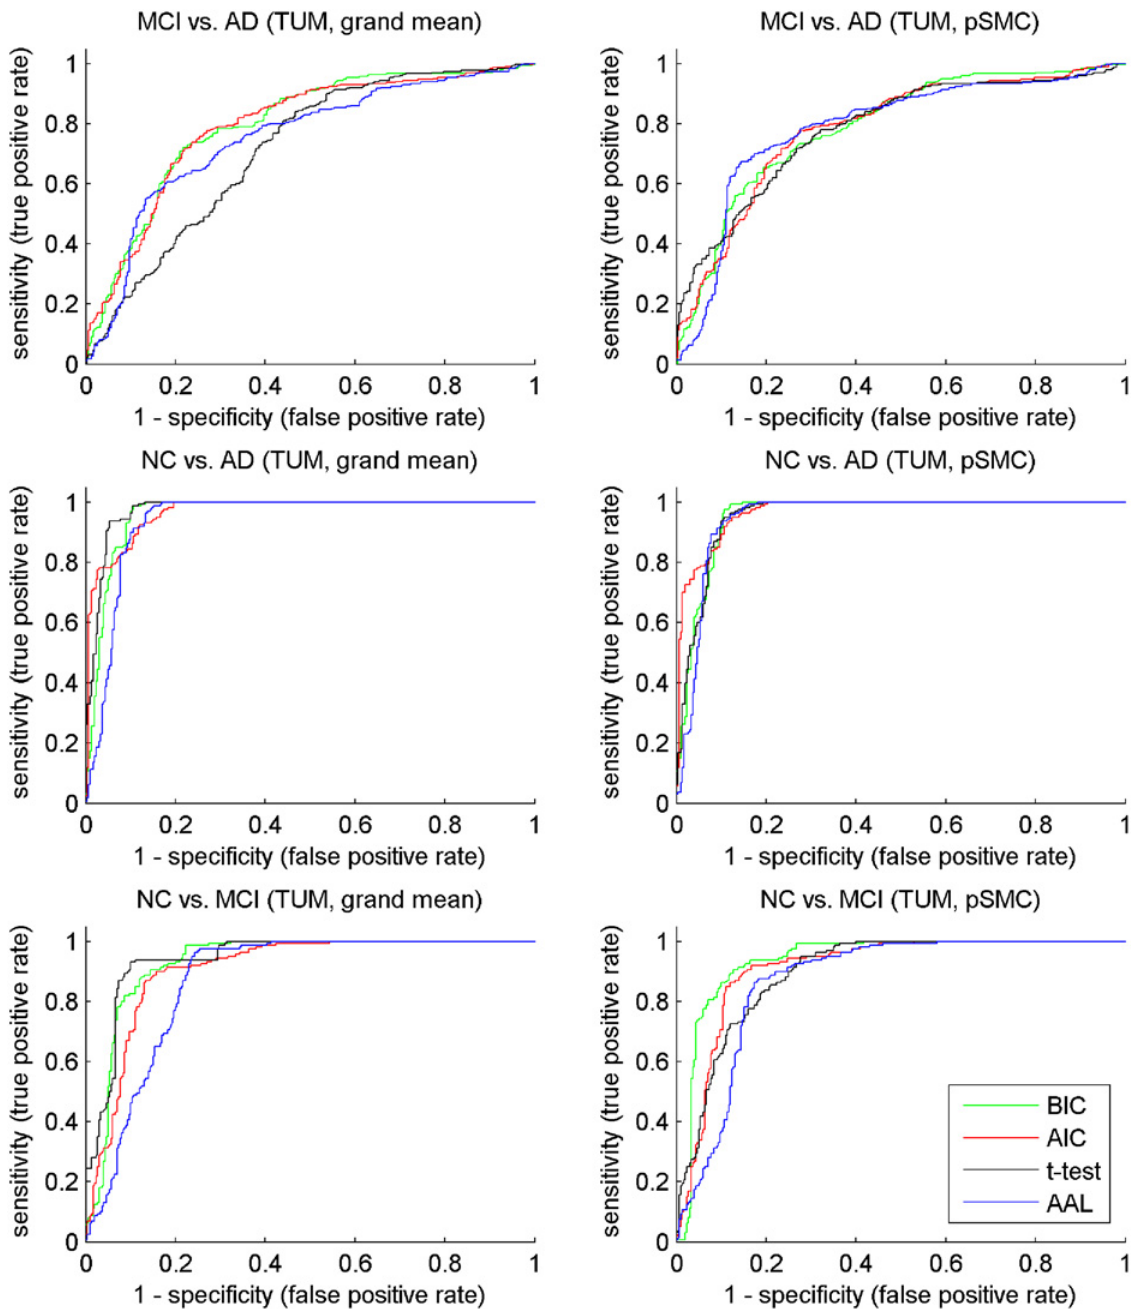
Fig 6. ROC curve of compared method on TUM